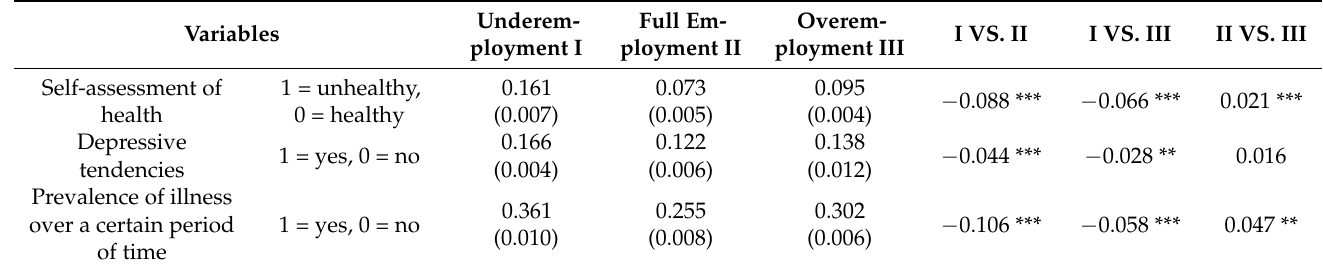
Table 2. Health disparities among workers with different employment status.